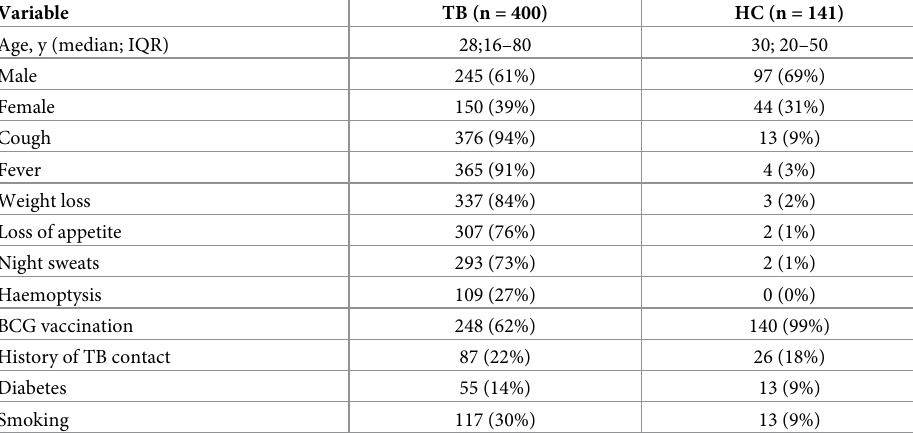
Table 2. Demographic data of TB patients and healthy